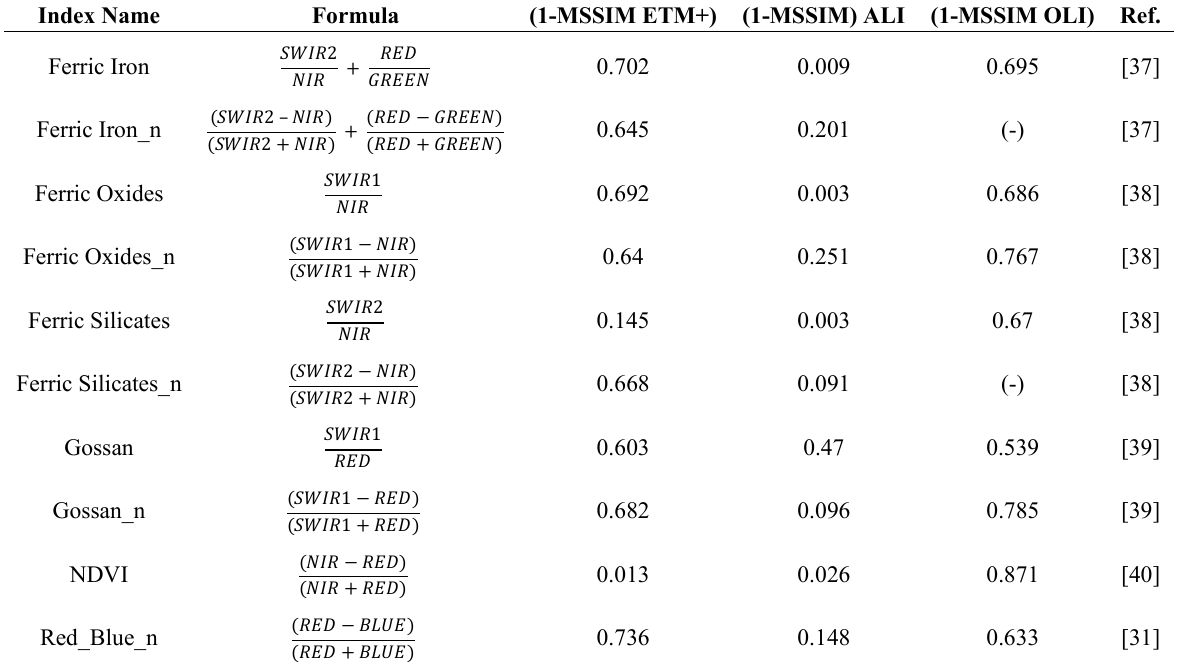
Table 1. Selected ratios that indicate ferric/ferrous iron, gossan and ferric silicates and the mean structural similarity index measure (MSSIM) between each ratio calculated from top at the atmosphere reflectance (TOAREF) data and reflectance data. The naming convention of the spectral bands in the formulas: near-infrared (NIR) in this case is the sensor band closest to 900 nm, whilst short wave infrared 1 (SWIR1) is the band closest to 1600 nm and short wave infrared 2 (SWIR2) is the last band of ALI, ETM+ and OLI. (-) shows that the calculation of 1-MSSIM was not possible in two cases, due to absence of data values in the ratio data. The smaller the 1-MSSIM values, the better the